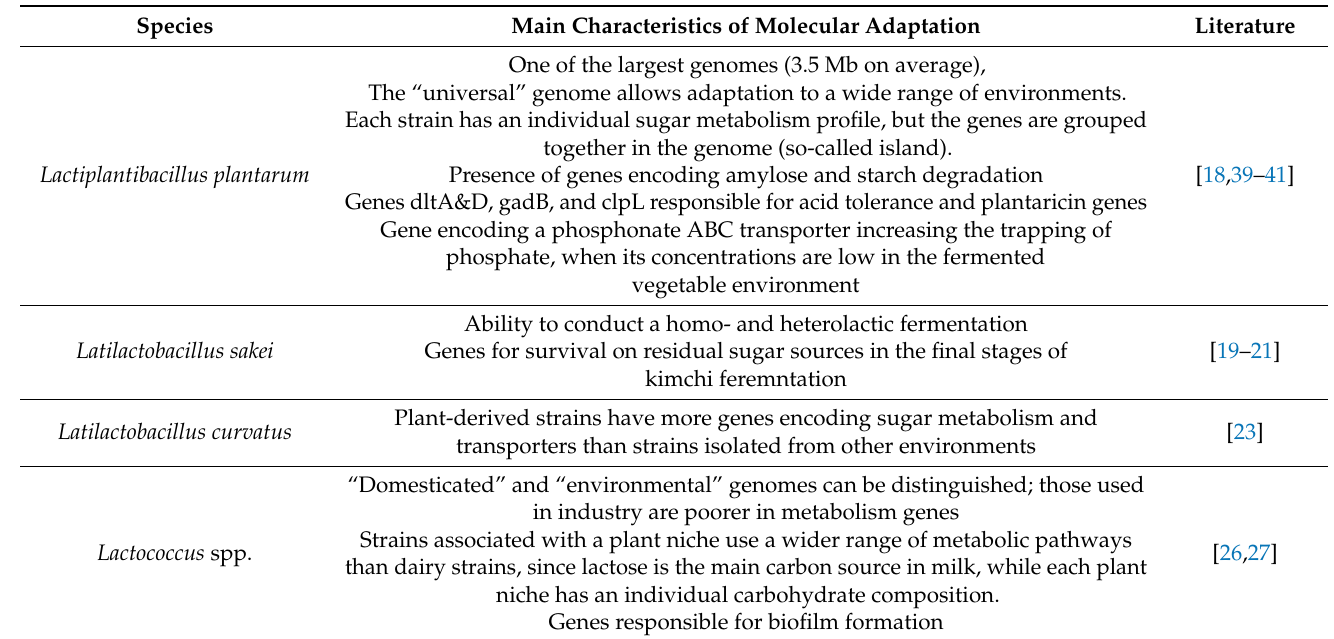
Table 1. Summary of key molecular features responsible for bacterial adaptation to the niche of fermented plant foods.